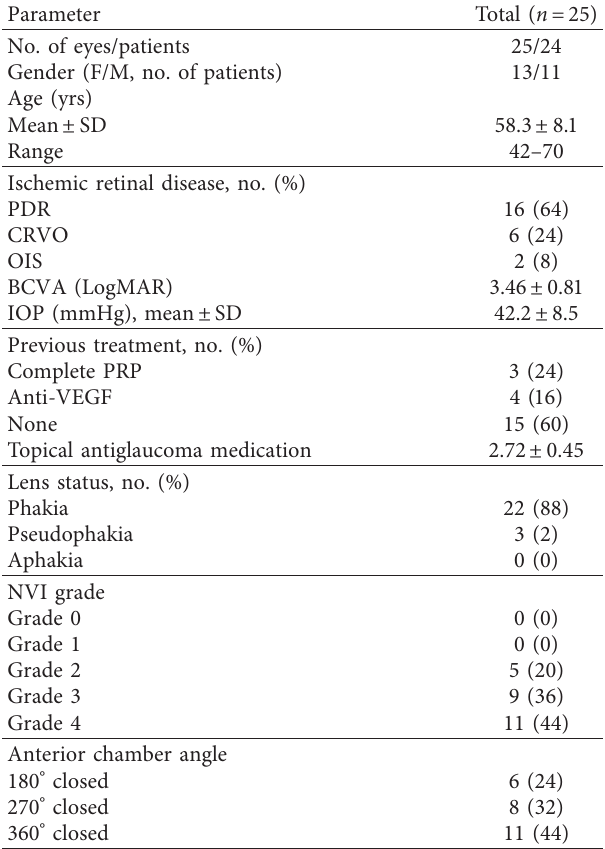
Table 1: Patient baseline